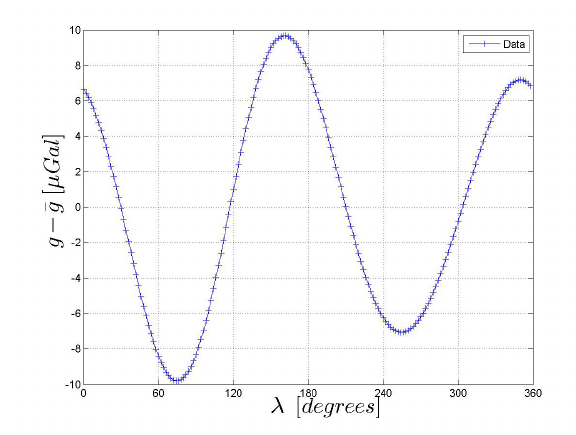
Figure 1: The vertical axis shows the difference of zero gravity from its mean value along the equator. λ -axis is longitude.